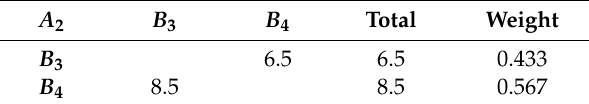
Table A9. Judgment matrix of B 3 – B 4 .